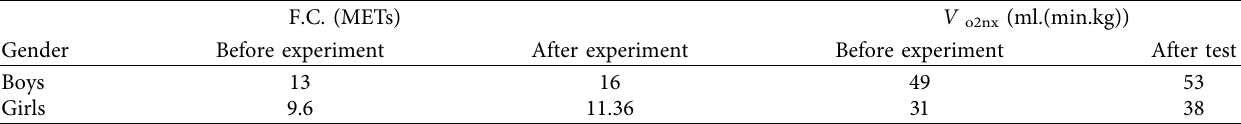
Table 4: Effect of 8-week maximum fat metabolism intensity exercise prescription on college students’ cardiopulmonary